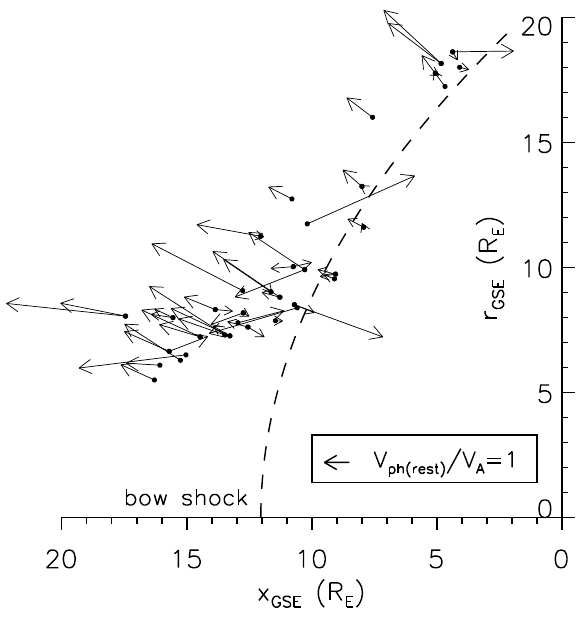
Fig. 6. Spatial distribution of wave phase velocities in the plasma rest frame plotted together with the location of wave observations, p y 2 + z 2 ). The phase veloci- projected into the xr plane in GSE ( r = ties are normalized to the local Alfv´en velocity. The dashed, curved line is a nominal bow